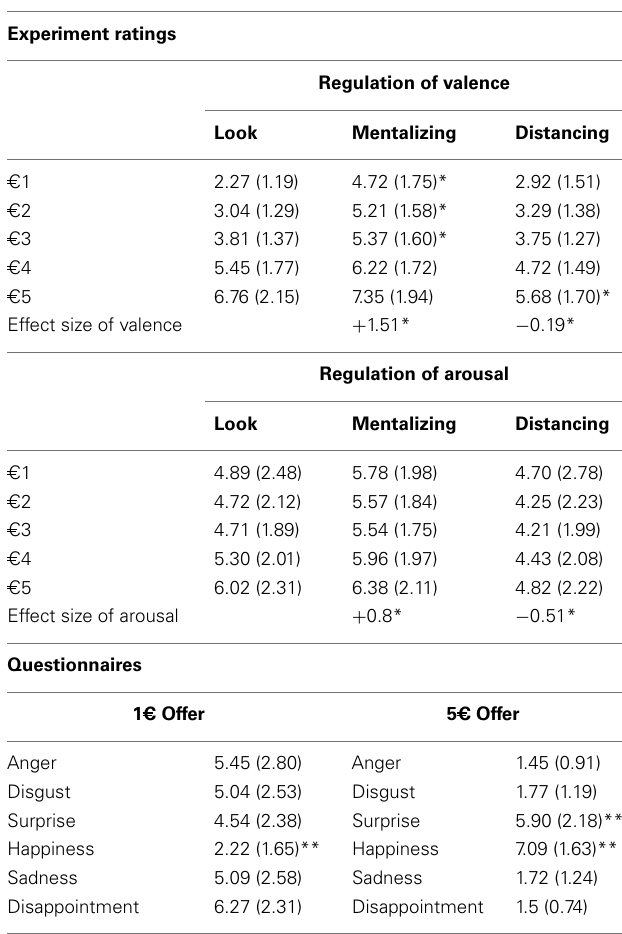
Table 1 | Experiment 1: results from the experiment and from the questionnaires.